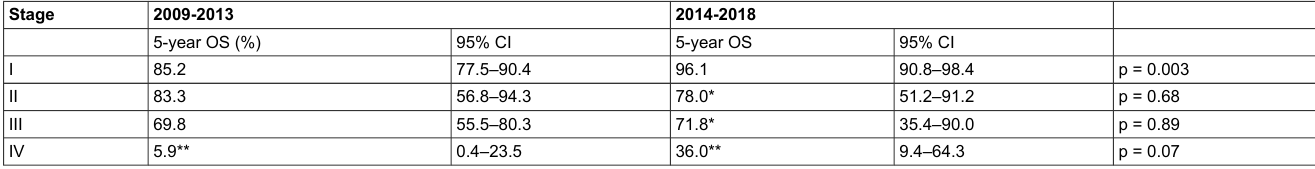
Table 4: Five-year overall survival by stage and period.